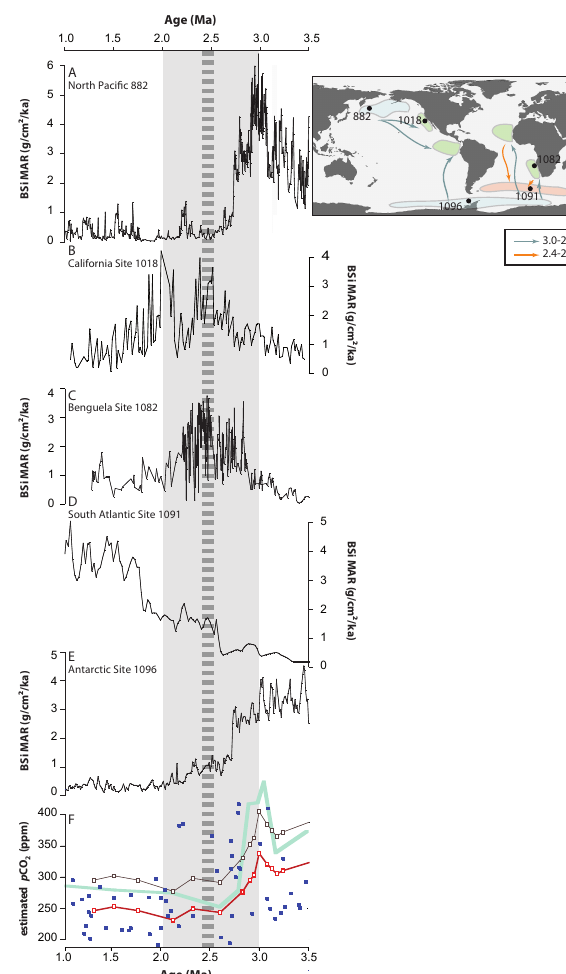
Fig. 4. BSi MAR at Sites (A) 882 (Maslin et al., 1996), (B) 1018 (Janecek, 2000), (C) 1082 (Etourneau et al., 2009), (D) 1091 (Cortese et al., 2004) and (E) 1096 (Hillenbrand and F ¨ utterer, 2001). (F) Atmospheric p CO 2 estimate derived from planktic foraminifera (blue line, Seki et al., 2010; blue square, Bartoli et al., 2011; H¨onisch et al., 2009) and alkenones (grey and red, Seki et al., 2010) at the Caribbean Site 999. The grey zone corresponds to the pe- riod of increasing siliceous productivity and decreasing p CO 2 as illustrated by the black arrows. The dashed line indicates the max- imum biogenic opal production during the MDM. The associated map shows the respective locations of the different sites and the major opal centres shift, from the Southern Ocean and the North Pacific (blue) to the low-latitudes upwelling regions (green) around 3.0–2.7Ma, and from the latter to the Atlantic sector of the South- ern Ocean (orange) around 2.4–2.0Ma (modified from Cortese et al.,